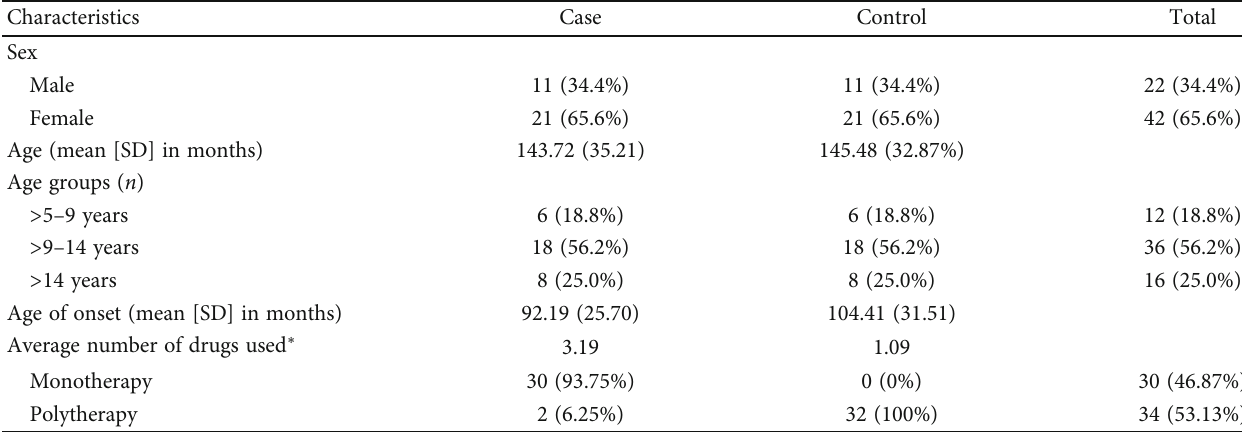
Figure 1: Flow diagram showing patients ’ selection. Table 1: Characteristics of subjects in the case and control groups.